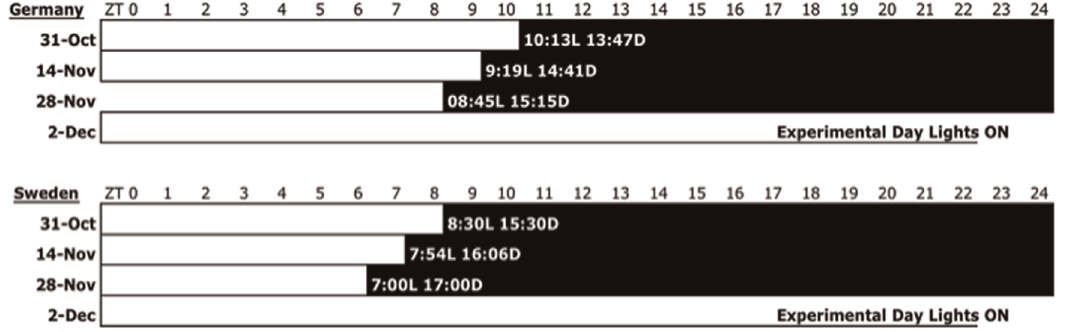
Figure 4. Environmental chamber light schedules for birds captured in Germany ( top panel ) and from Sweden ( lower panel ) at two- week intervals before the experimental day when tissue was collected ( 2-Dec ) at pre-critical photoperiods ( 6&10 hr after dawn ), at 11, 12, 14, 18 and 22 hr after dawn.